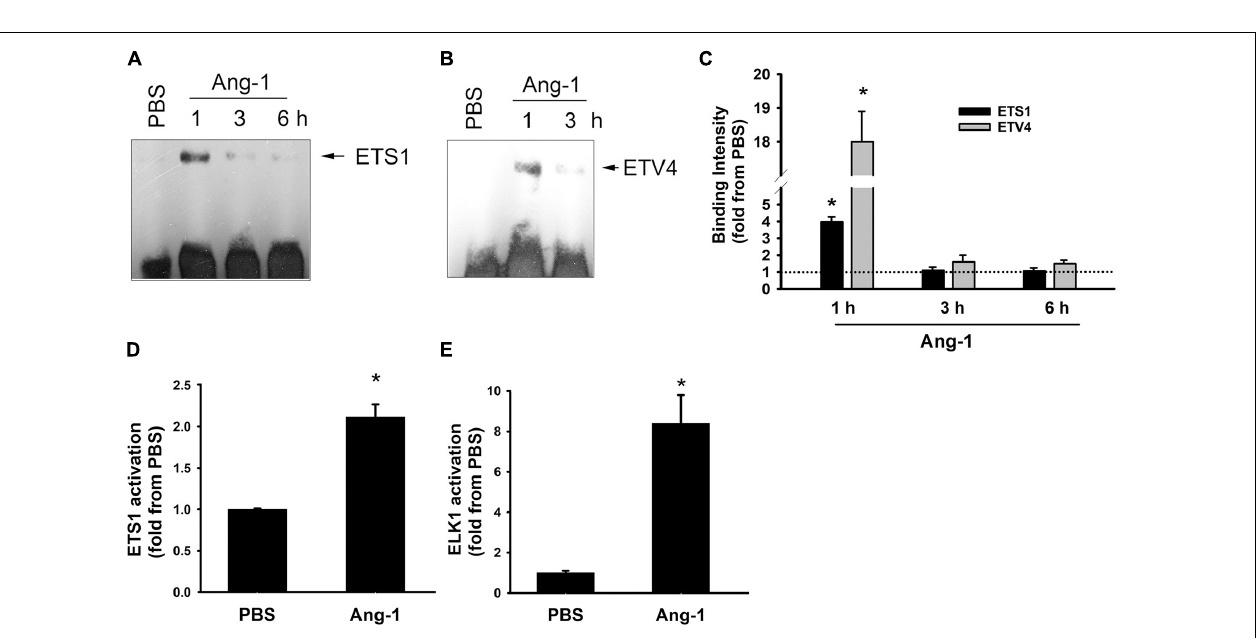
Frontiers in Physiology |